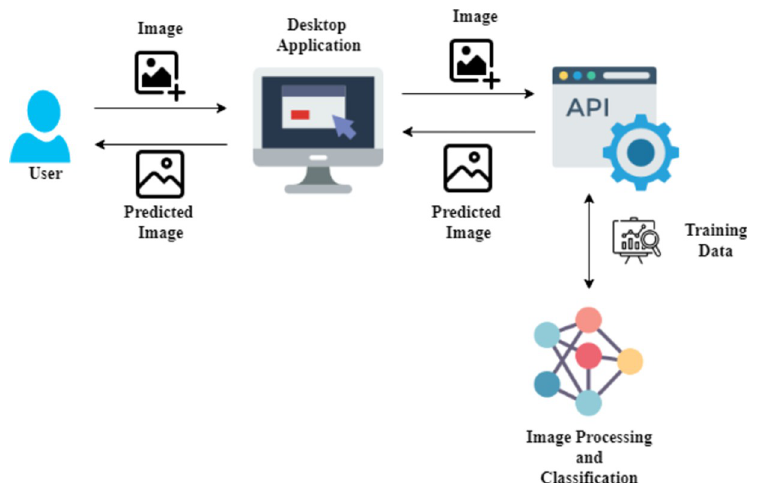
Fig 1. High-level architecture of the